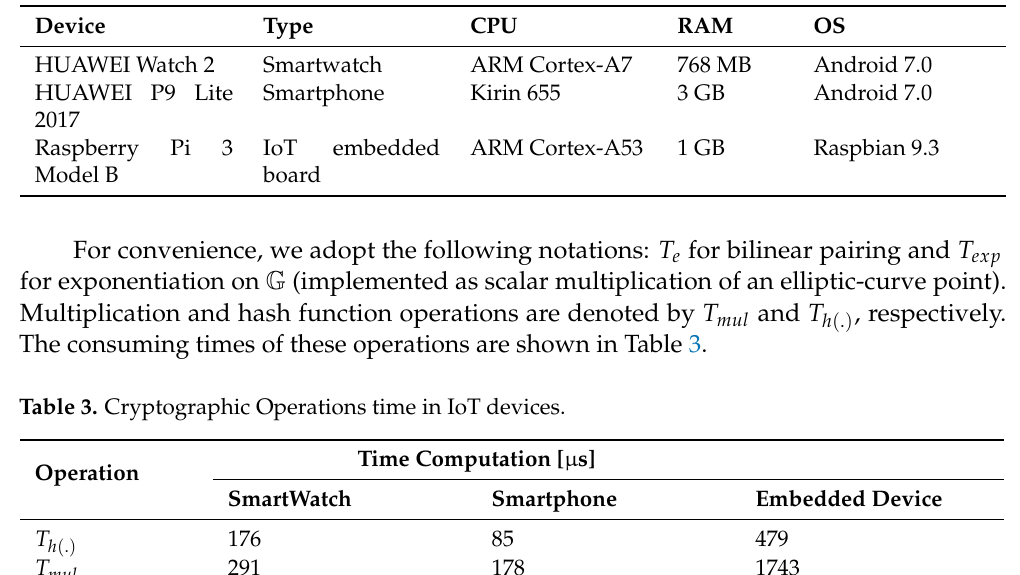
Table 2. IoT devices specifications.